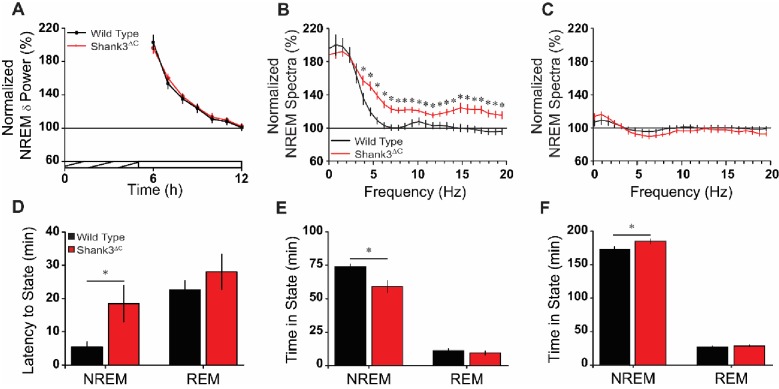
Shank3∆C mice take longer to fall asleep and sleep less after sleep deprivation.(A) Normalized NREM delta (δ; 0.5–4 Hz) power during recovery sleep post-sleep deprivation. The cross-hatched bar on the x-axis denotes the 5 hr sleep deprivation period and the open bar denotes the remaining light period. Repeated measures ANOVA. (B) Normalized NREM spectra for the first 2 hr post-sleep deprivation (hours 6–7; significant from 3.9 to 19.5 Hz). One-way ANOVA with posthoc unpaired t-tests using Benjamini-Hochberg correction. (C) Normalized NREM spectra for the last 2 hr of the light period post-sleep deprivation (hours 11–12). One-way ANOVA. (D) Latency to enter NREM sleep and REM sleep after sleep deprivation. Unpaired t-test. (E) Time in NREM sleep and REM sleep for the first 2 hr post-sleep deprivation (hours 6–7). Unpaired t-test. (F) Time in NREM sleep and REM sleep for the remaining 5 hr of light period post-sleep deprivation (hours 8–12). Unpaired t-test. Values are means ± SEM for wild type (n = 10; black) and Shank3∆C (n = 10; red) mice. *p<0.05, difference from wild type.
10.7554/eLife.42819.013Figure 3—source data 1.Source data and summary statistics used for generating plots for Figure 3.

10.7554/eLife.42819.014Figure 3—source data 2.Statistical results for Figure 3, Figure 3—figure supplement 1, and Figure 3—figure supplement 2.numDF, numerator degrees of freedom. denDF, denominator degrees of freedom.